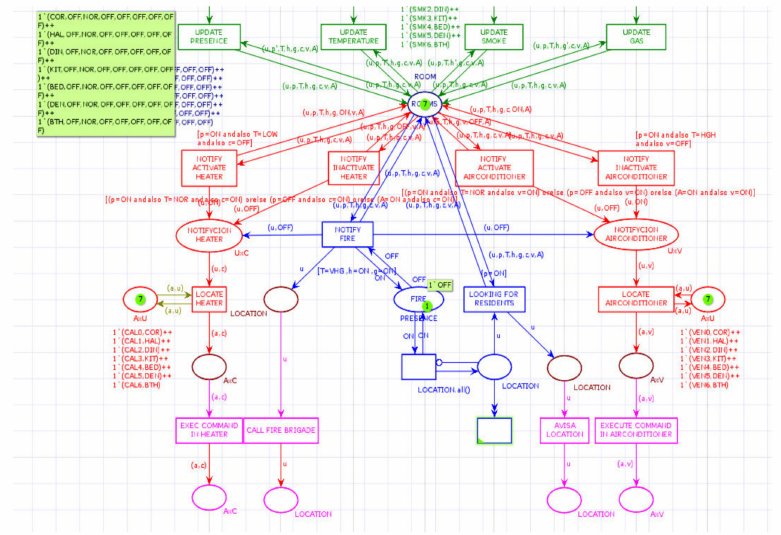
Figure 7. CPN subscription for notification and collection